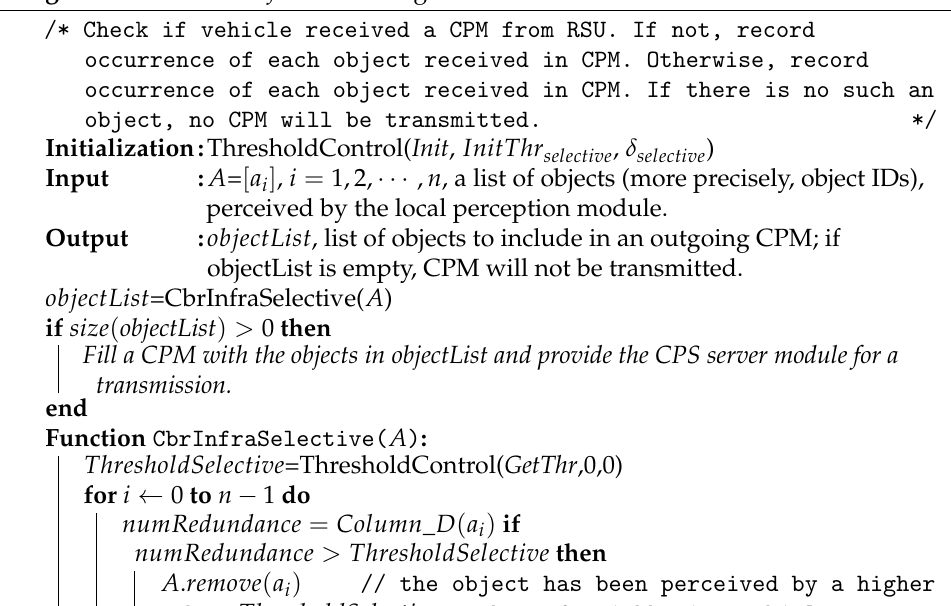
Algorithm 4: CBR & Infra selective